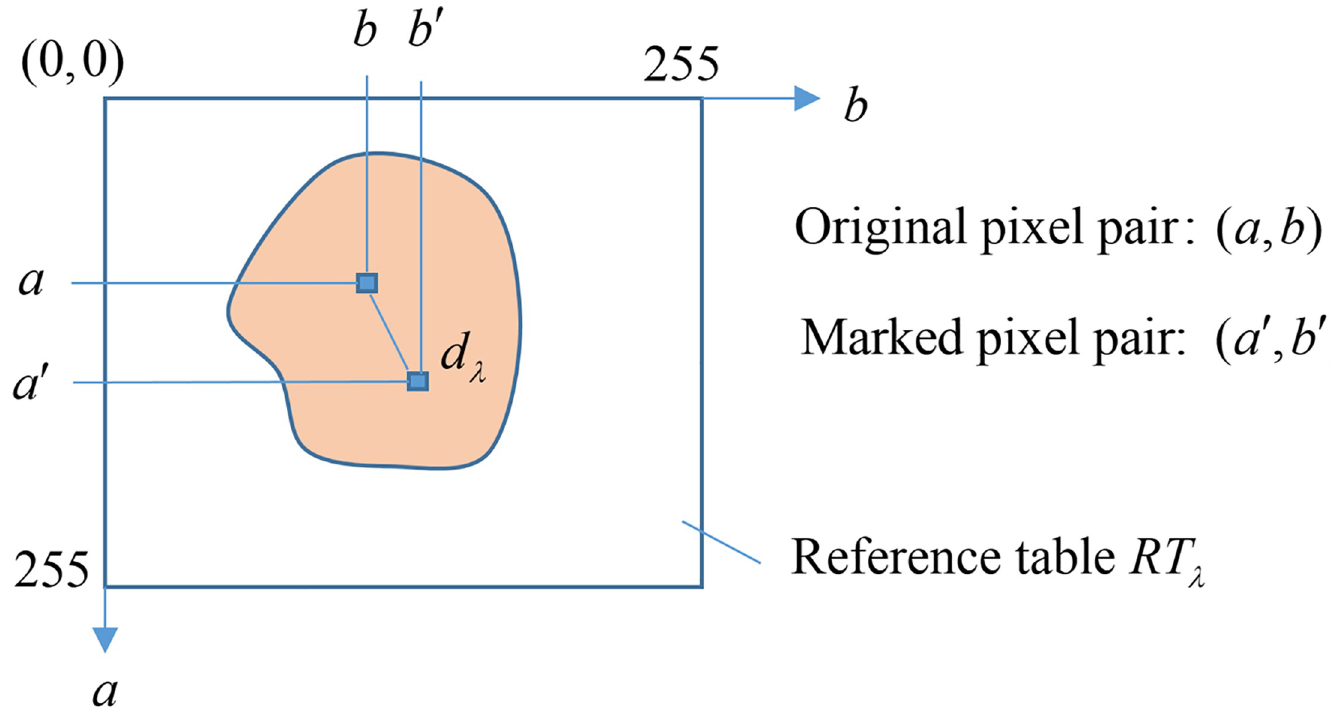
Fig 1. The illustration of RT-based embedding technique.